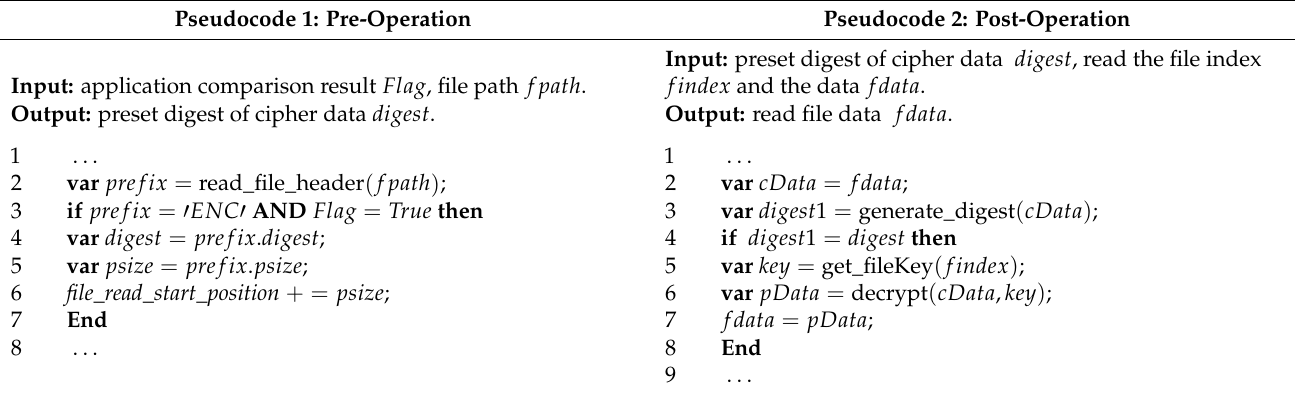
Table 2. File filtering